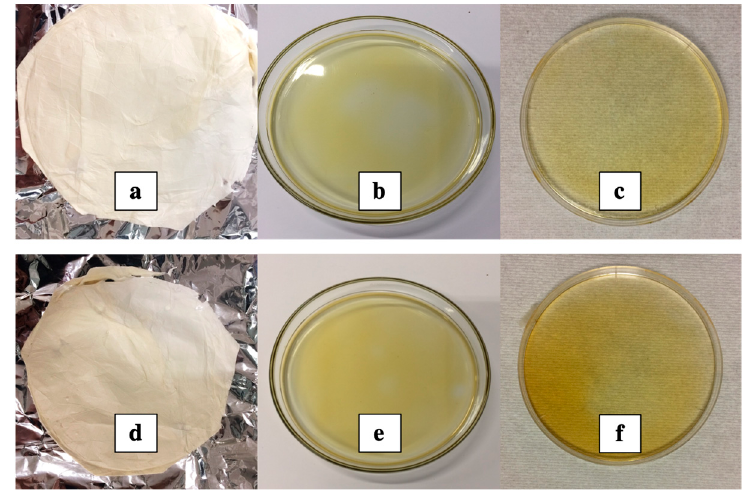
Figure 2. Unloaded zein films obtained through ( a ) electrospinning, ( b ) solvent casting, and ( c ) spin coating, SCG 45% w/w loaded zein films obtained through ( d ) electrospinning, ( e ) solvent casting and ( f ) spin coating.